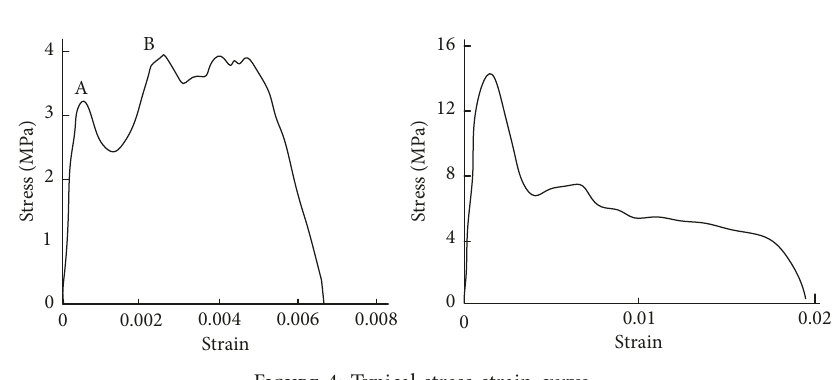
Figure 4: Typical stress-strain curve.